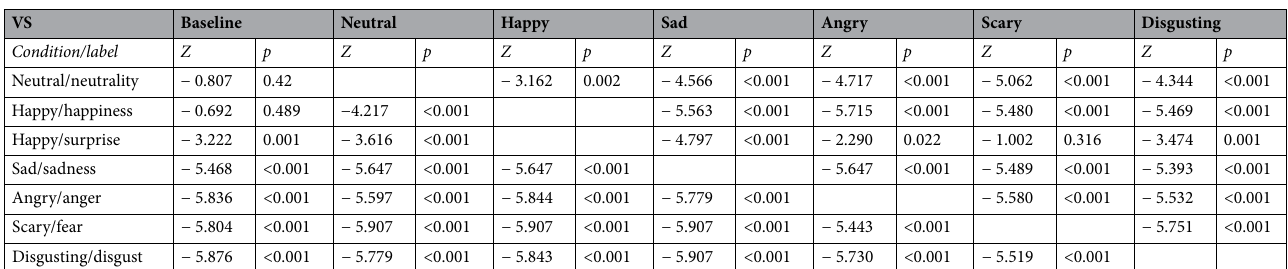
Table 1. Exp. 1—comparison of each label in the condition with the highest rating and all other conditions.